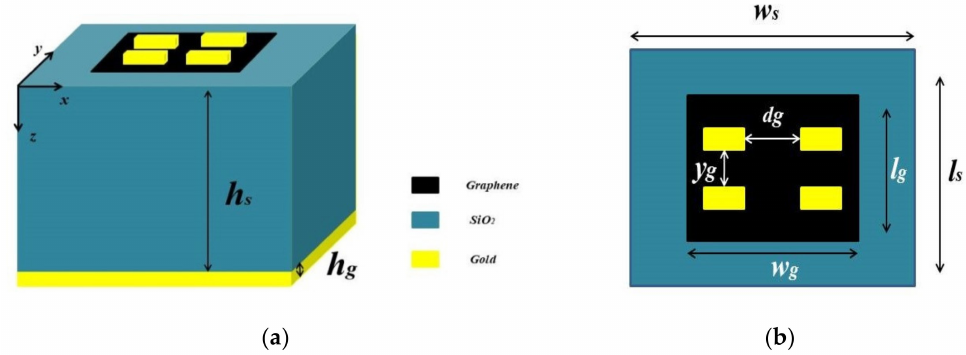
Figure 1. ( a ) 3D view of the graphene based absorber. ( b ) 2D top view of the presented absorber.